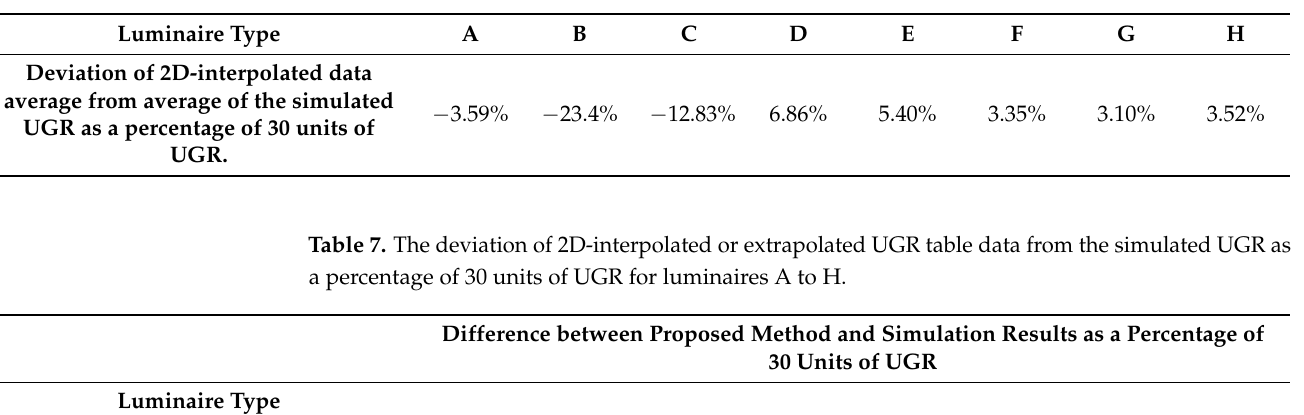
Table 6. The deviation of 2D-interpolated or extrapolated data average from average of the simulated UGR as a percentage of 30 units of UGR for luminaires A to H.